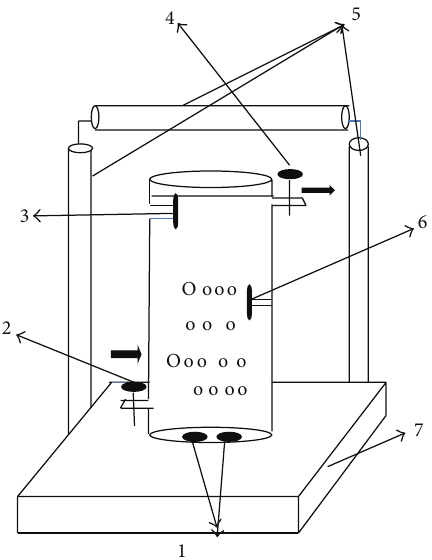
Figure 1: The shematic configuration of the photocatalytic reactor (1) magnets, (2) the inlet of OMW, (3) heater for temperature adjustment, (4) the outlet of OMW, (5) UV or sunlight lamps [each one of UV ( 100 W ∗ 3 ) or sunlight (30 W)], (6) pH meter, (7) magnetic stirrer, respectively.